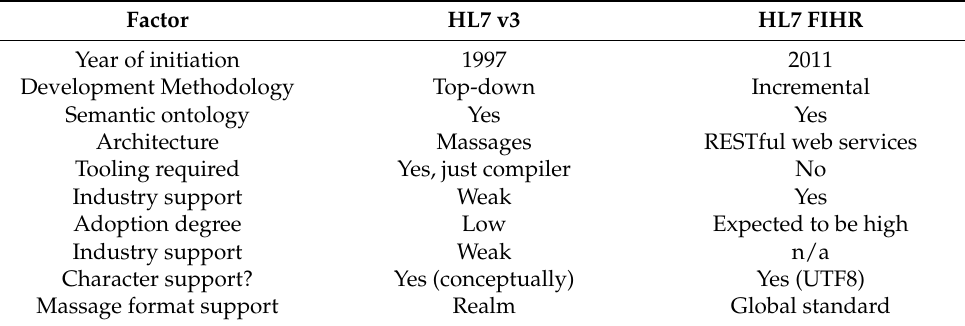
Table 6. Comparison between HL7 v3 and HL7 FIHR